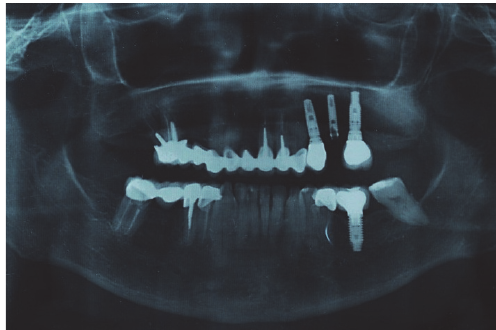
Figure 1: Panoramic radiograph. Implant (2.5) with fracture screw and hex devastated